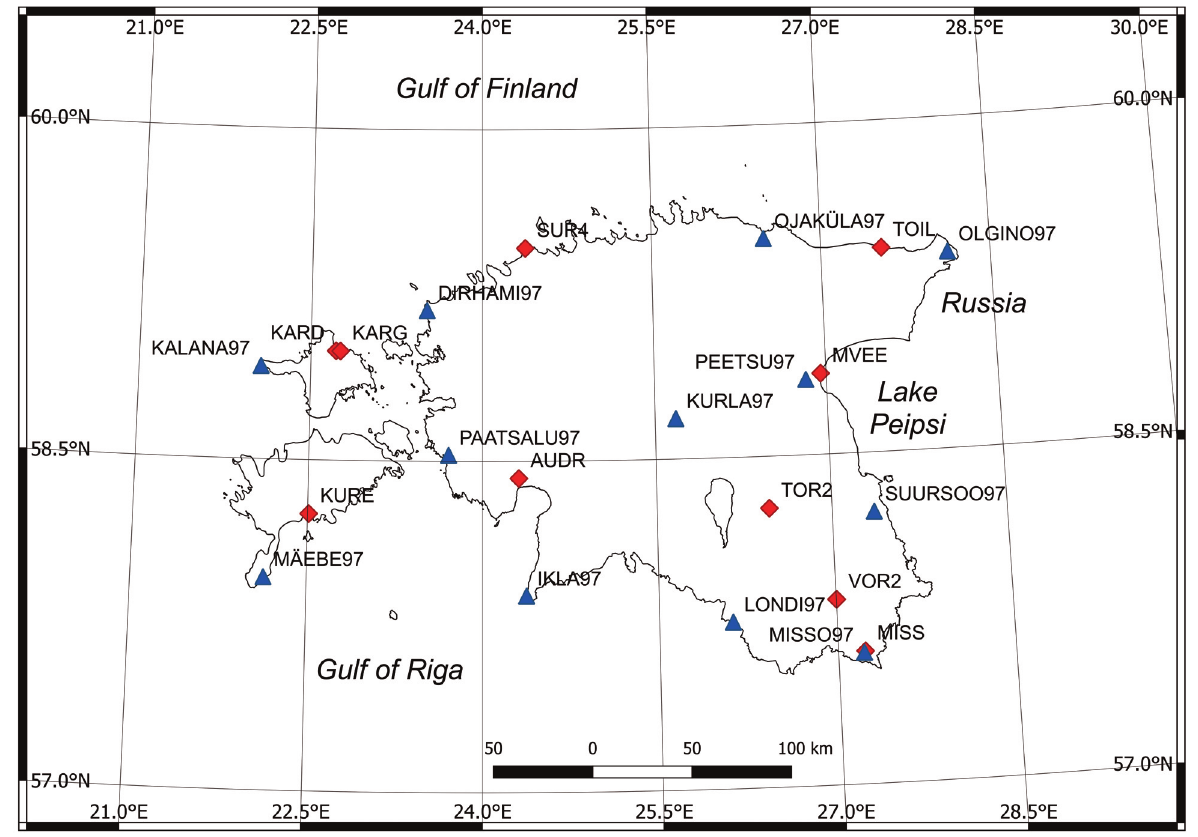
Fig. 1. The 1st-order national geodetic reference network points (blue triangles) and continuously operating GNSS reference stations used in this study (red